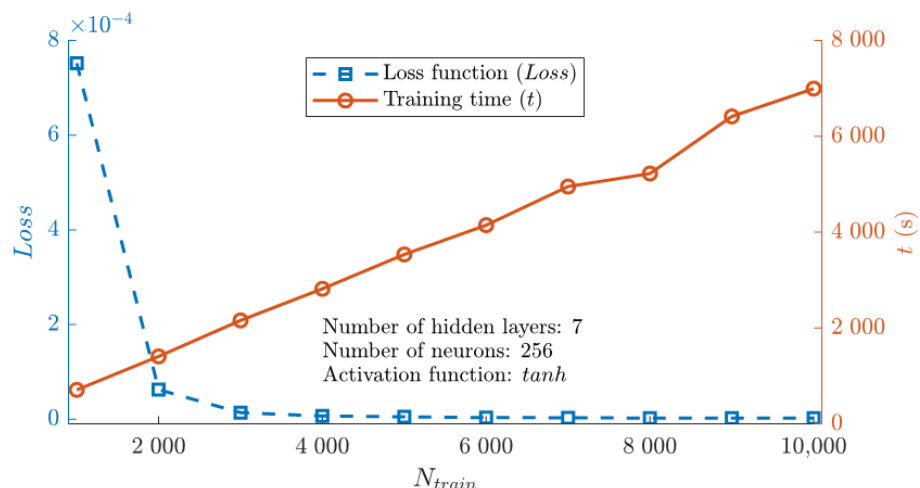
Figure 7. Influence of the number of training data points ( N train ) on the loss function ( Loss ) and training time ( t ).